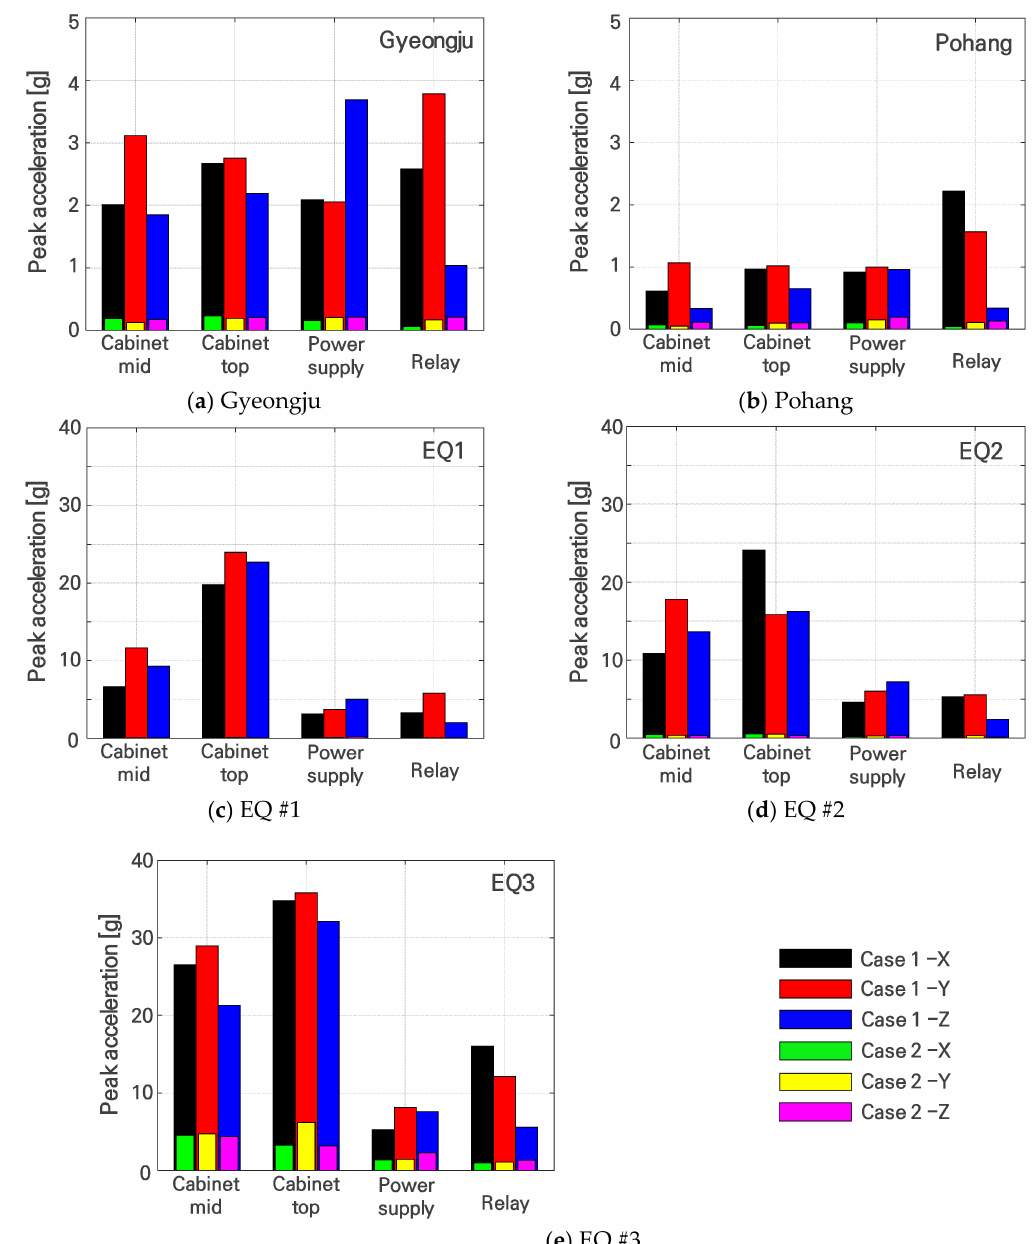
Figure 12. Comparison of peak acceleration